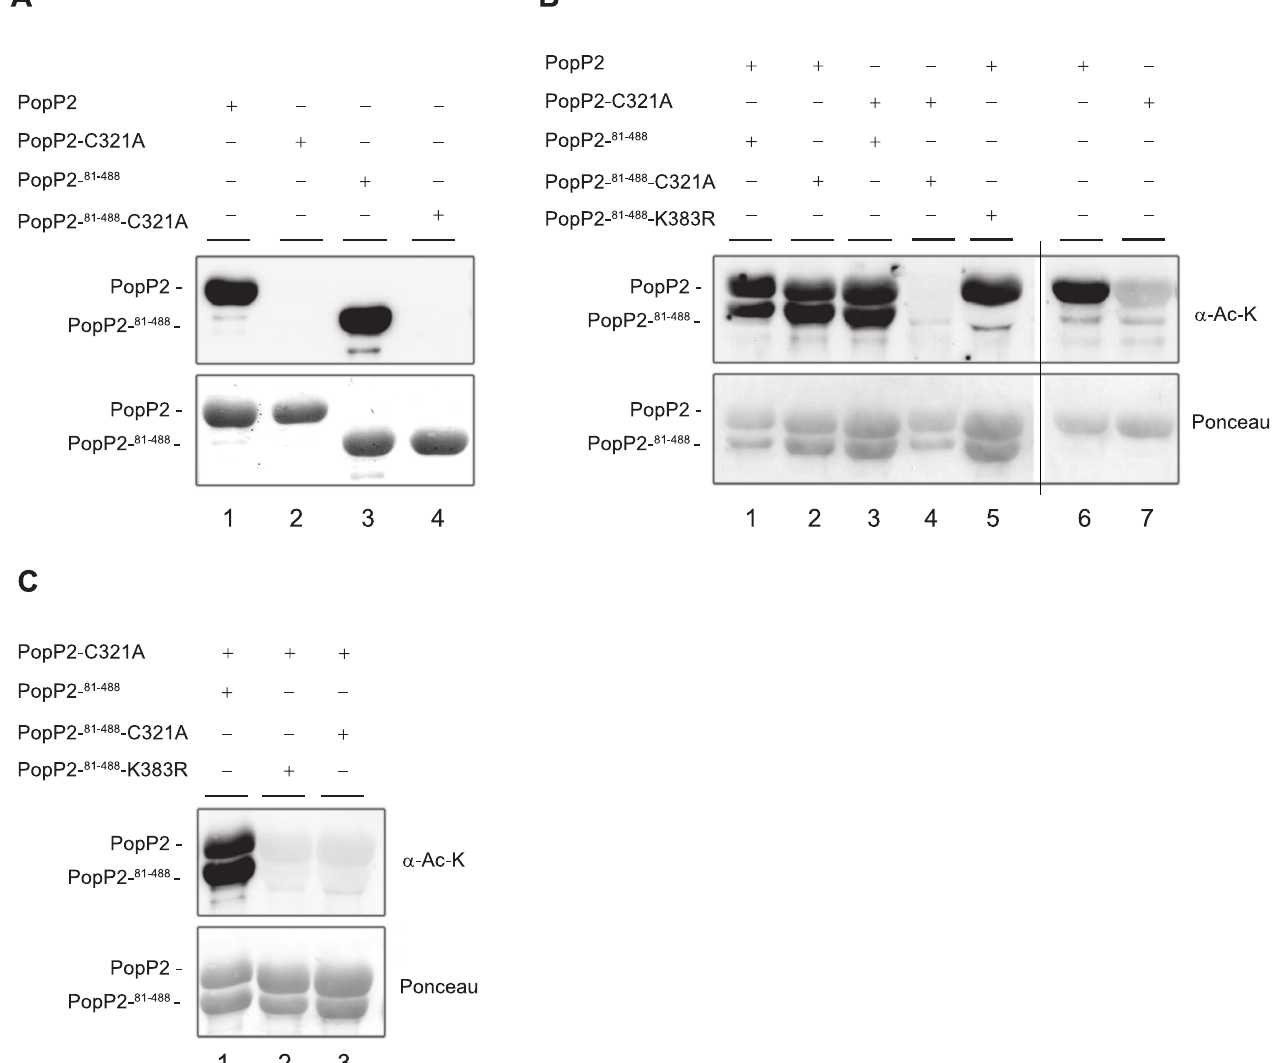
Fig 7. Intermolecular autoacetyl-transferase activity of PopP2 is dependent on the integrity of K383 residue. A : A truncated form of PopP2 that lacks its first 80 amino acids (PopP2- 81-488 ) retains its acetyltransferase activity. B : Detection of acetylated forms of GST-PopP2-C321A and GST-PopP2-C321A- 81-488 upon co-expression with GST-PopP2- 81-488 and GST-PopP2, respectively (lanes 2 and 3). K383R mutation prevents GST-PopP2 to acetylate GST-PopP2- 81-488 - K383R in trans (lane 5). The black line indicates image splicing (lanes 1 to 5 and lanes 6–7 are from the same experiment consisting in two membranes). C : Detection of acetylated forms of GST-PopP2-C321A upon co-expression with GST-PopP2- 81-488 (lane 1) but not with GST-PopP2-C321A 81-488 (lane 2) or GST-PopP2- 81-488 -K383R (lane 3). The indicated protein combinations were purified from E . coli and their acetylation status tested by immunoblot with an α - Ac-K antibody. The position of acetylated proteins is indicated by dashes (top). GST-purified PopP2 recombinant proteins are shown after Ponceau staining (bottom). A, B and C represent three independent experiments carried out under identical conditions.